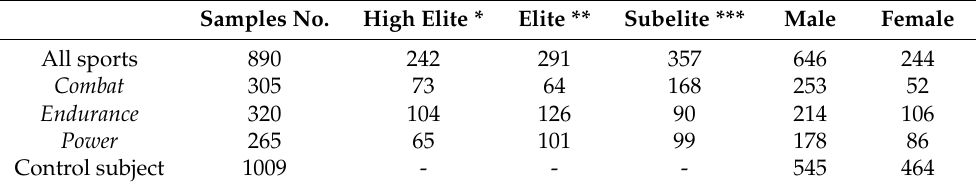
Table 1. Characteristics of study groups. Samples No. High Elite